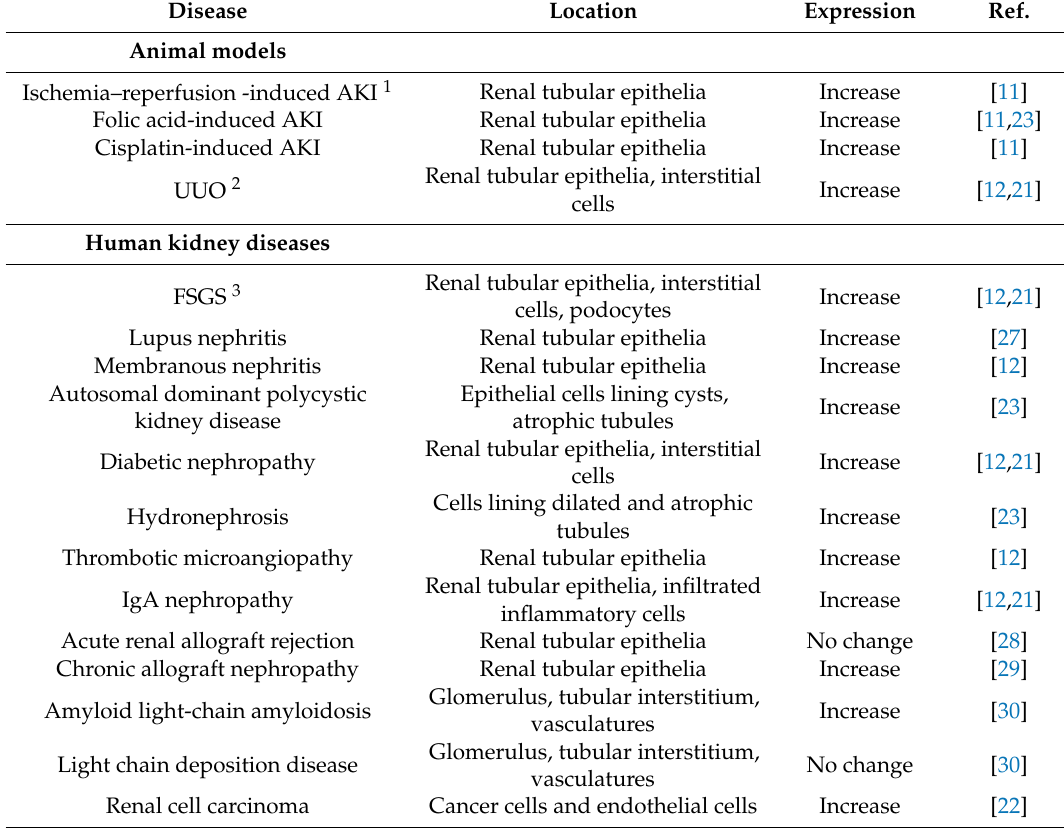
Table 1. Expression of matrix metalloproteinase-7 (MMP-7) in kidney